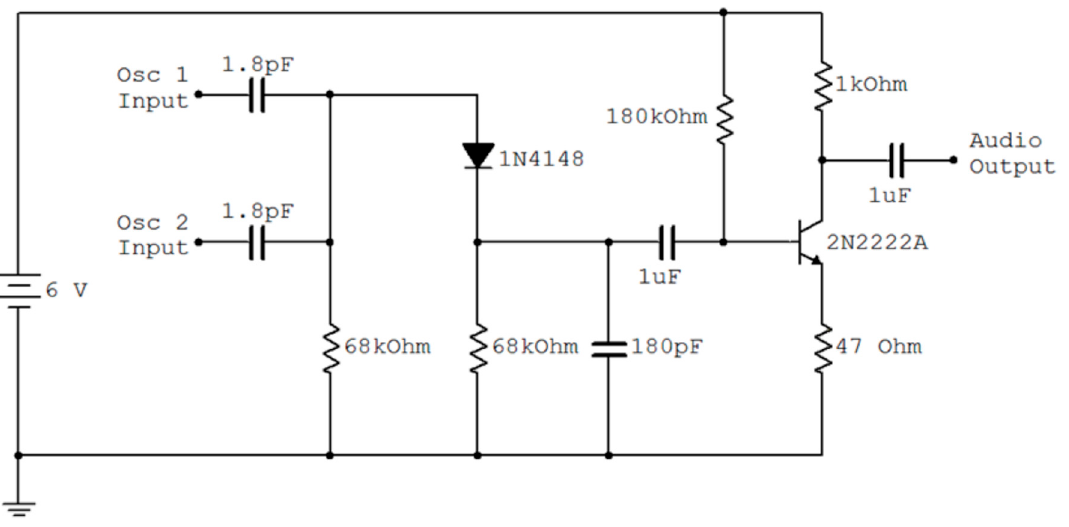
Figure 8. Mixer, filter and buffer circuit diagram